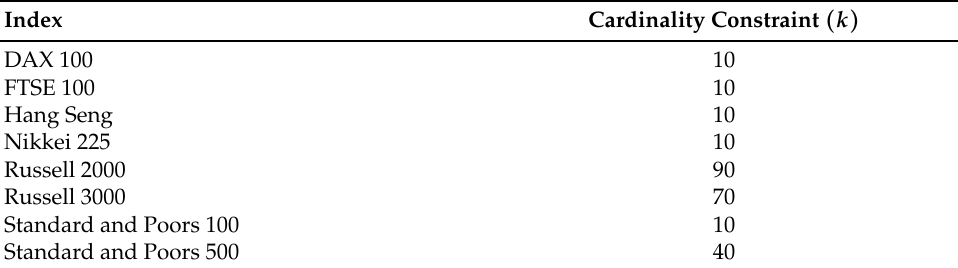
Table 3. Indices and Number of Constituents in Tracking-Portfolios.